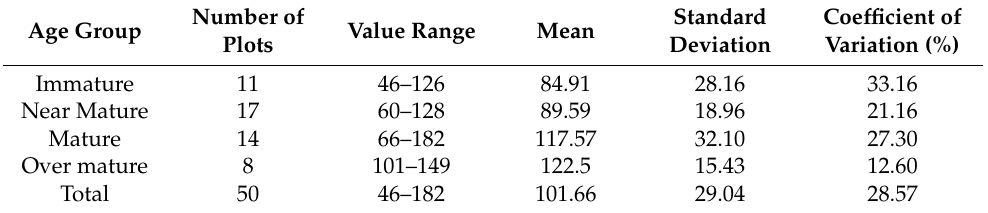
Table 2. The AGB observed in the sample plots